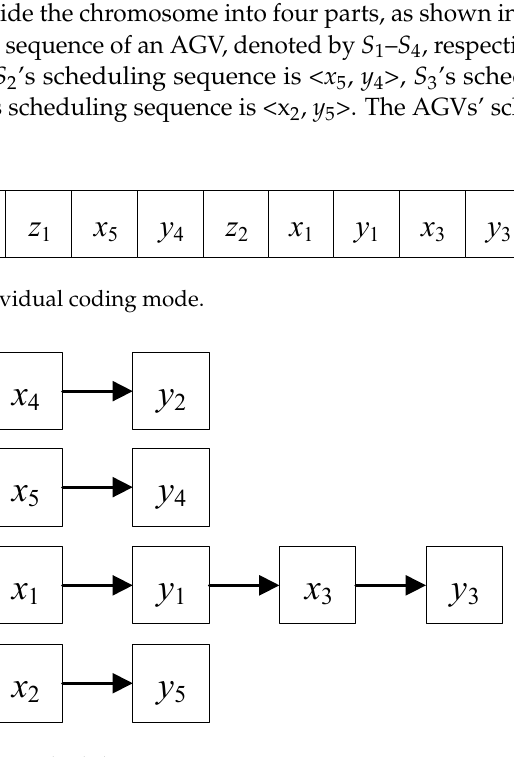
Figure 3. AGVs’ scheduling sequence.